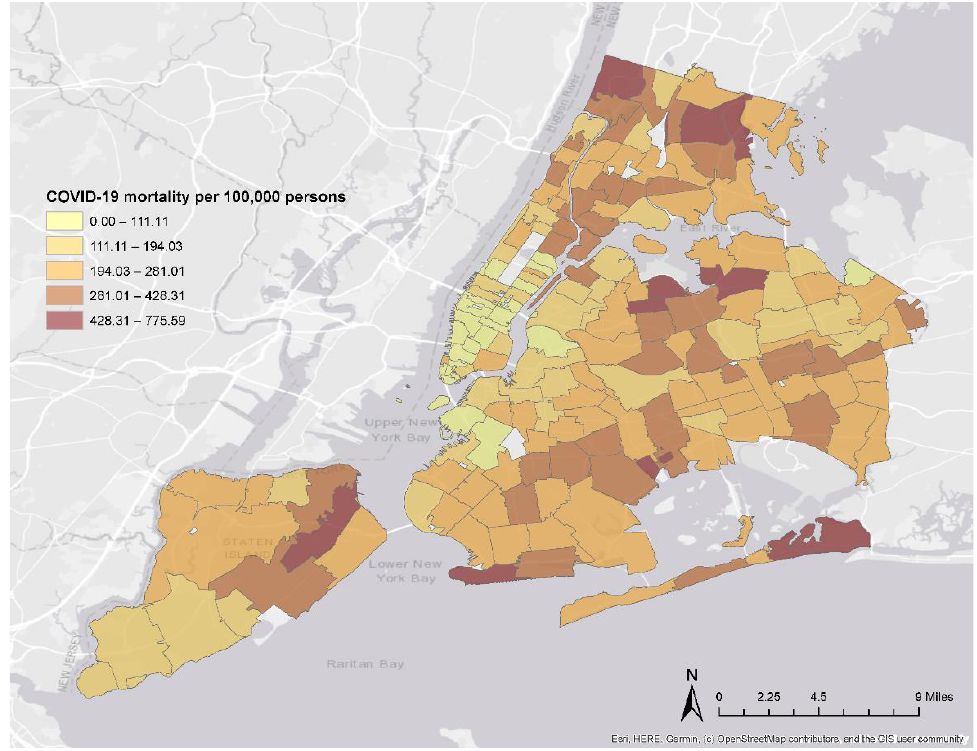
Figure 1 . New York City ZIP Code Tabulation Area COVID-19 Mortality Rates . Figure 1. New York City ZIP Code Tabulation Area COVID-19 Mortality